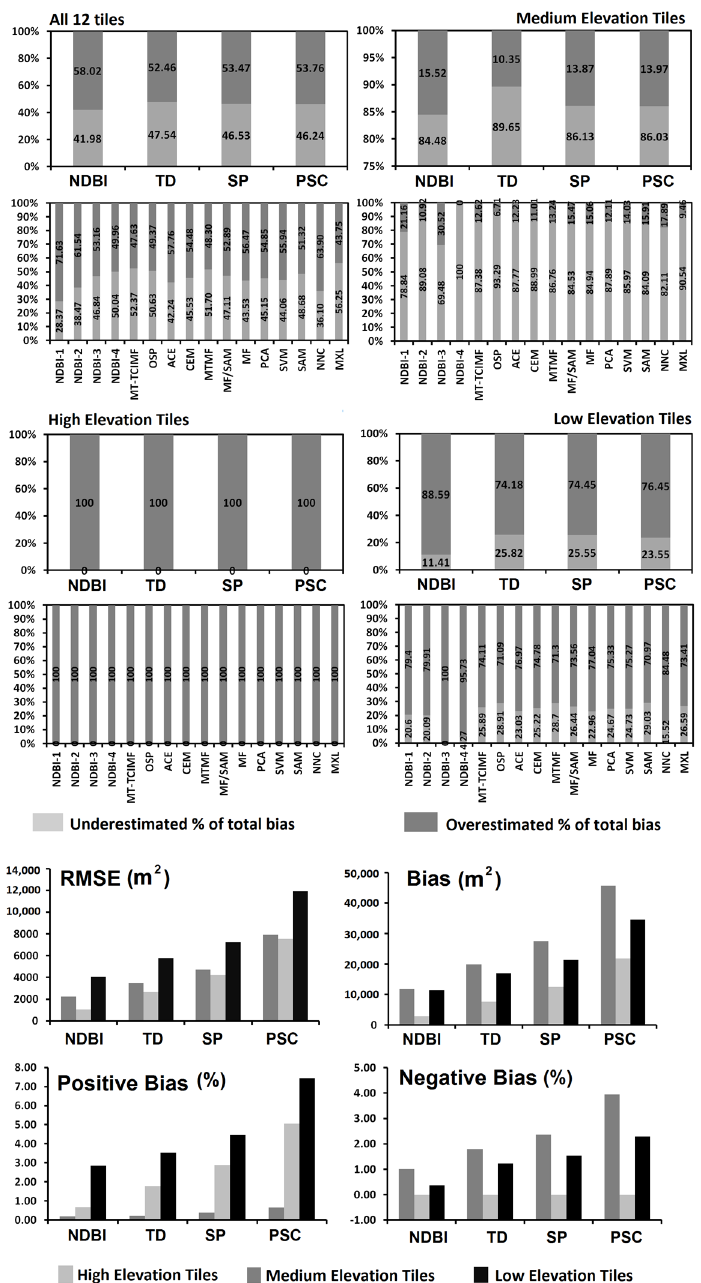
Figure 8. The overall performance of the extraction methods for extracting all the 12 tiles and effect of topographic variation on the accuracy of extracting BIRs, based on misclassified (underestimated or overestimated) area (%). The statistic is depicted for varying topographic tiles separately, i.e., moderate elevation tiles, low elevation tiles and high elevation tiles. The figure also depicts variations of positive bias (m 2 ), negative bias (m 2 ), RMSE (m 2 ) and total bias (m 2 ) for the four feature extraction approaches implemented for blue ice